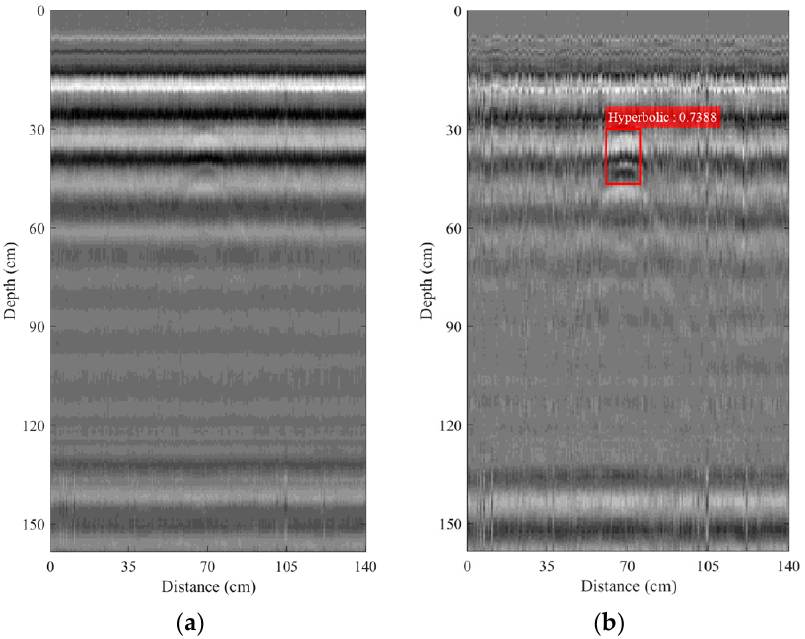
Figure 13. B-scan images collected by using the pickup truck-mounted GPR system on a road: ( a ) without any pre-processing; ( b ) with zero offset and background removals.